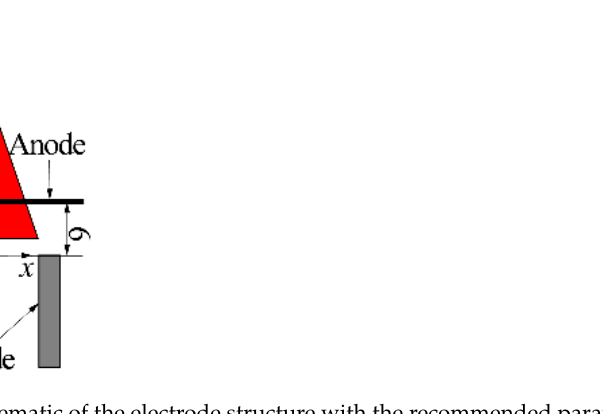
Q  = 100 L/h, I stepped from 0 μ A to 4.09 μ A when f